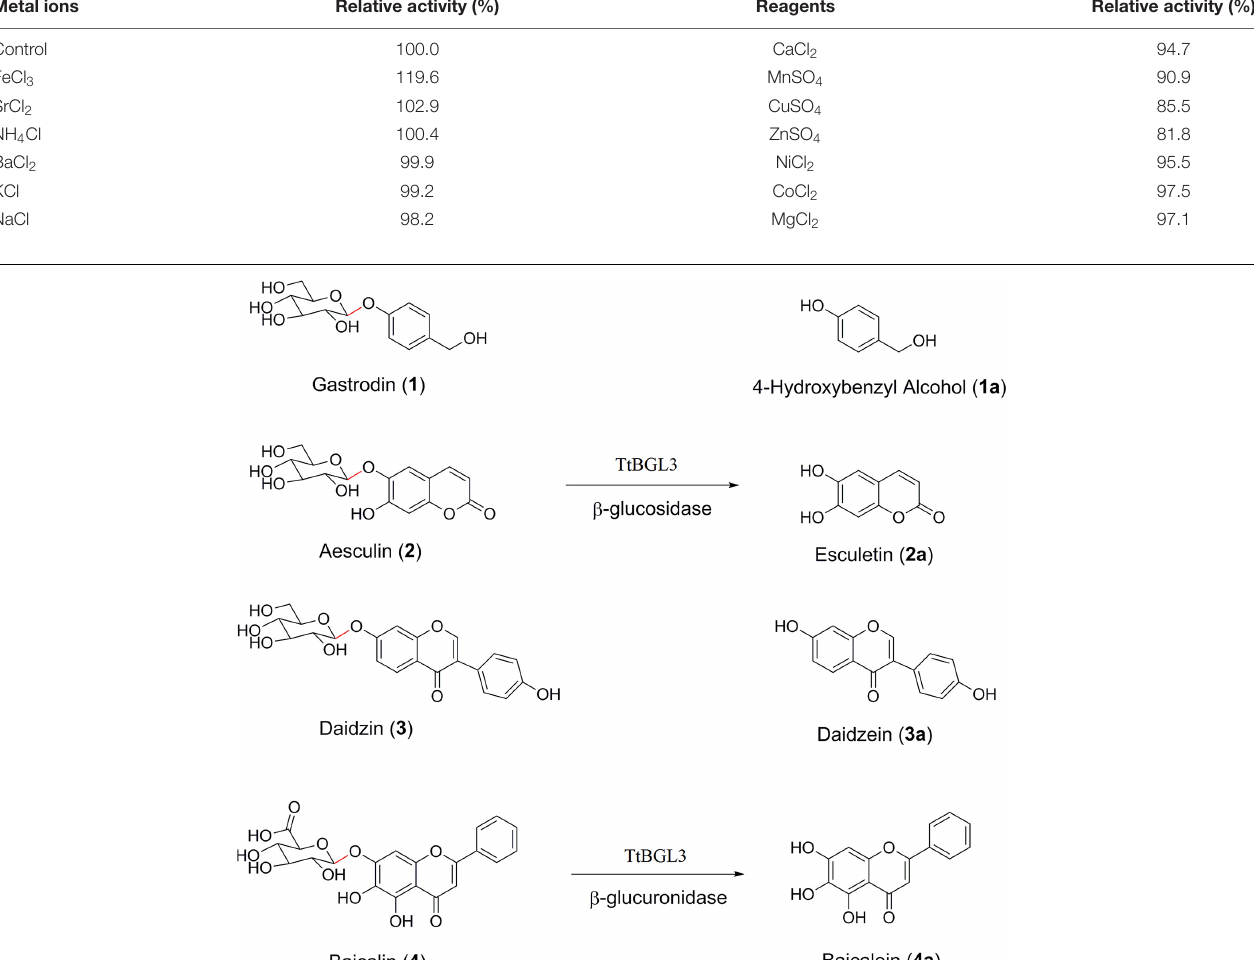
TABLE 2 | Effects of metal ions at the concentration of 10 mM on TtBgl3 activity.